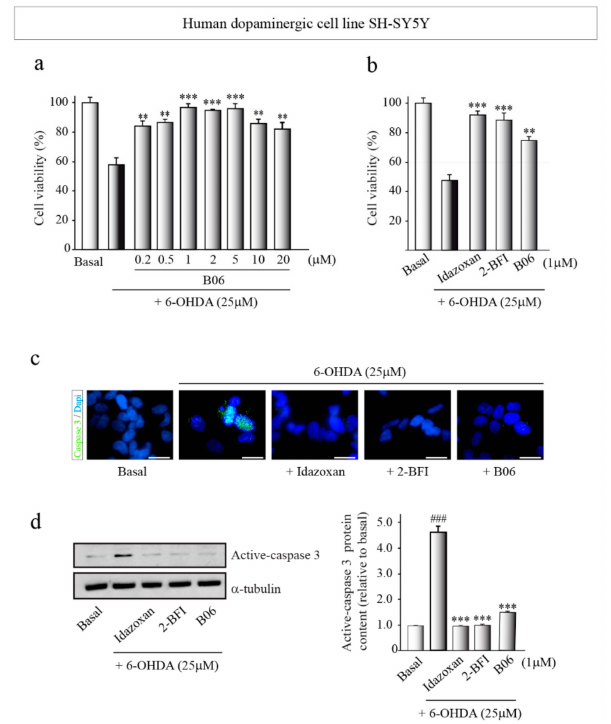
Figure 7. Phenotypic screening of I 2 -IR ligands. Neuroprotective effect of B06 in vitro. Human dopaminergic cell line SH-SY5Y was exposed to 6-OHDA (25 µ M) for 16 h. Cell viability was determined by MTT assay. Values represent the mean ± SD from triplicate determinations repeated at least three times. ** p ≤ 0.01, *** p ≤ 0.001 versus 6-OHDA-treated cultures. ( a ) Dose– response curve of B06 . In order to determine the optimal dose of use of B06 for in vitro analysis, different concentrations of B06 were used. ( b ) To evaluate the neuroprotective role of B06 , some cultures were pre-treated with idazoxan, 2-BFI and B06 (1 µ M) for 1 h before 6-OHDA treatment. Apoptotic levels were determined by active caspase 3 (green) immunodetection ( c ) and Western blot quantification ( d ). Representative images of at least three independent experiments are shown. Scale bar, 10 µ m. Nuclei were counterstained with DAPI (blue). *** p < 0.001 versus 6-OHDA-treated cells. ### p < 0.001 versus control (basal)